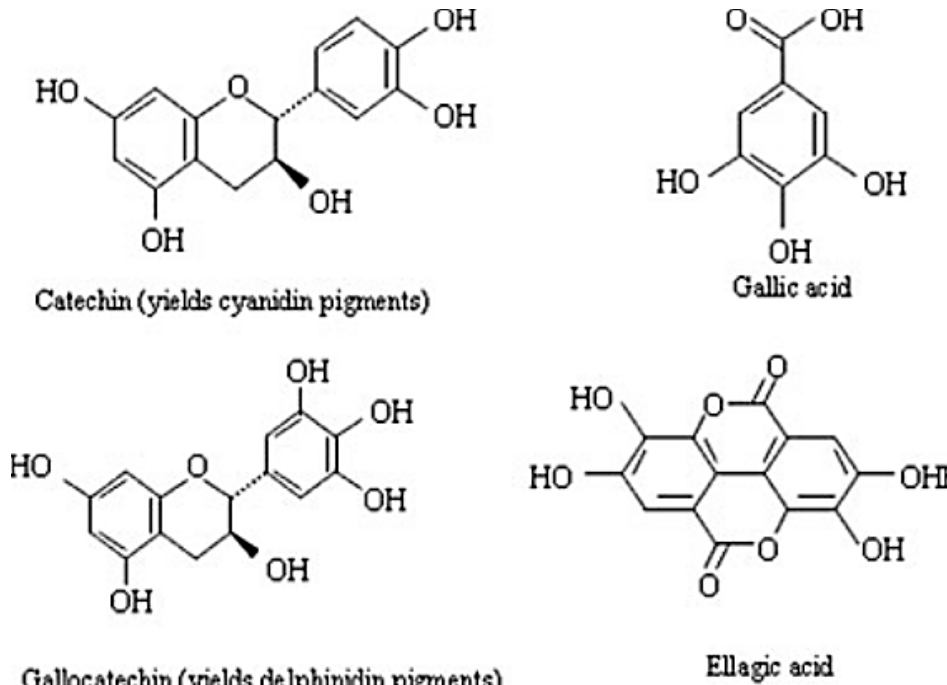
Figure 2. Monomeric units of condensed (catechin and gallocatechin) and hydrolysable tannins (gallic and ellagic acid) [62].